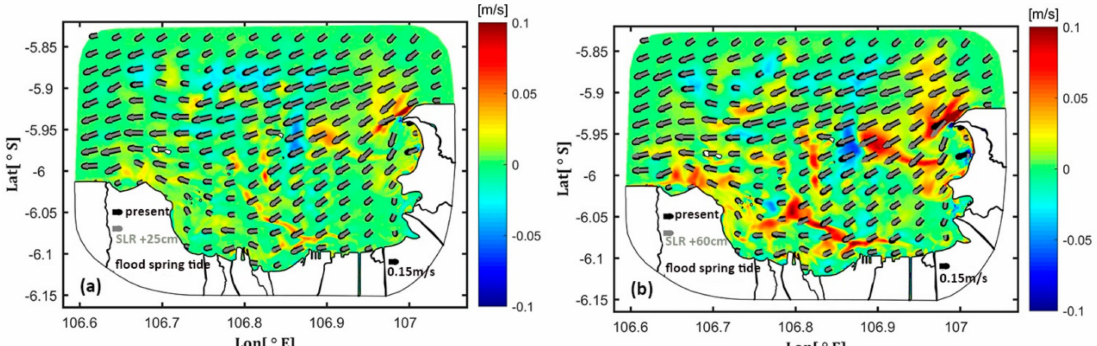
Figure 10. Di ff erences in surface current velocity (m / s) and direction under flood condition spring tide ( a ) scenario 2a and ( b ) scenario 2b. Black vectors are for scenario 1, and grey vectors are for scenario 2a / 2b. Color contours indicate the change in magnitude (m / s) of the surface current velocity.